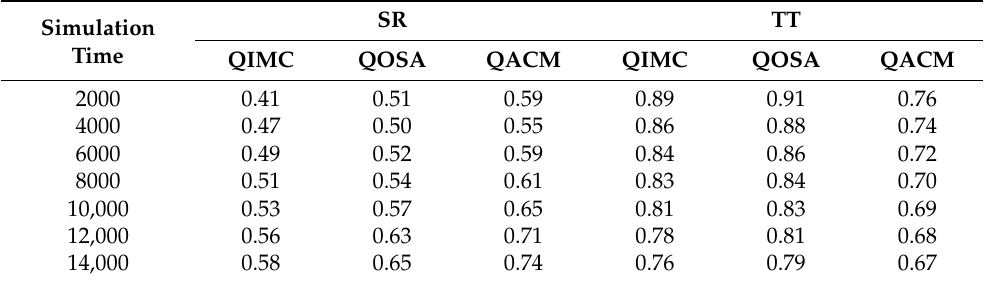
Table 2. Comparative values of SR and TT of QACM with QIMC and